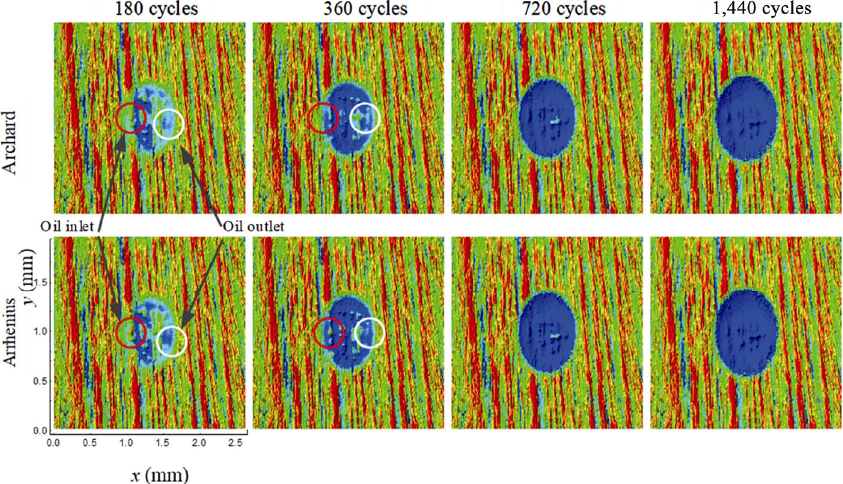
Fig. 18 Simulation of disk